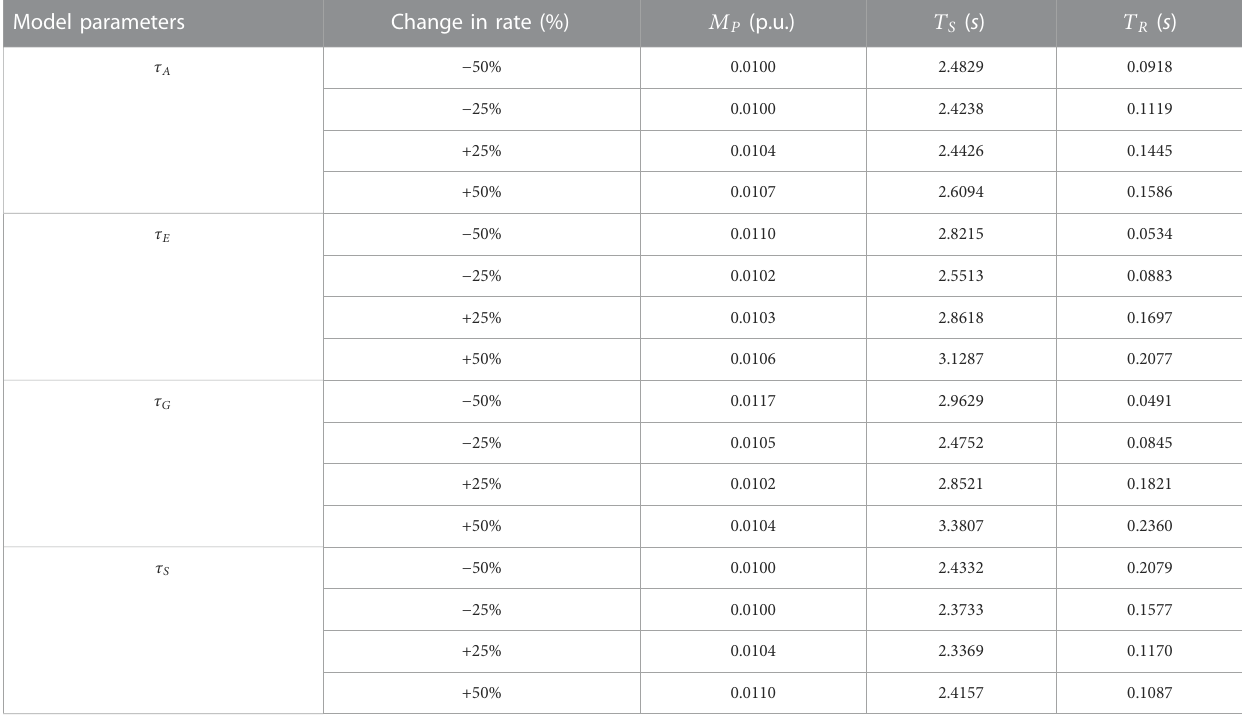
TABLE 3 Robustness examination for MFO-based PIDD 2 technique. Model